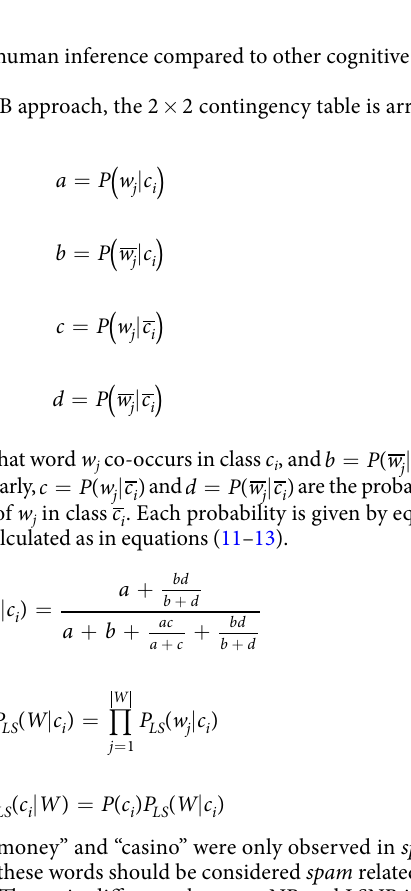
w j w j d Table 2. Contingency table used in the LSNB